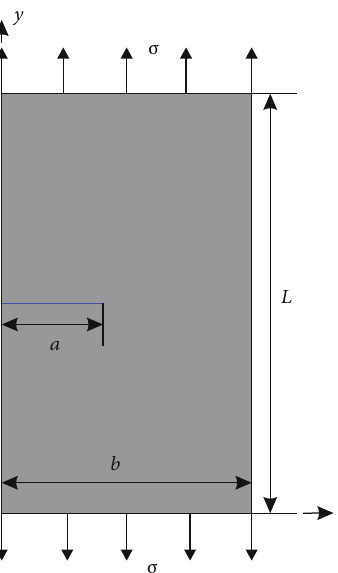
Figure 5: Calculationmodelfor fi